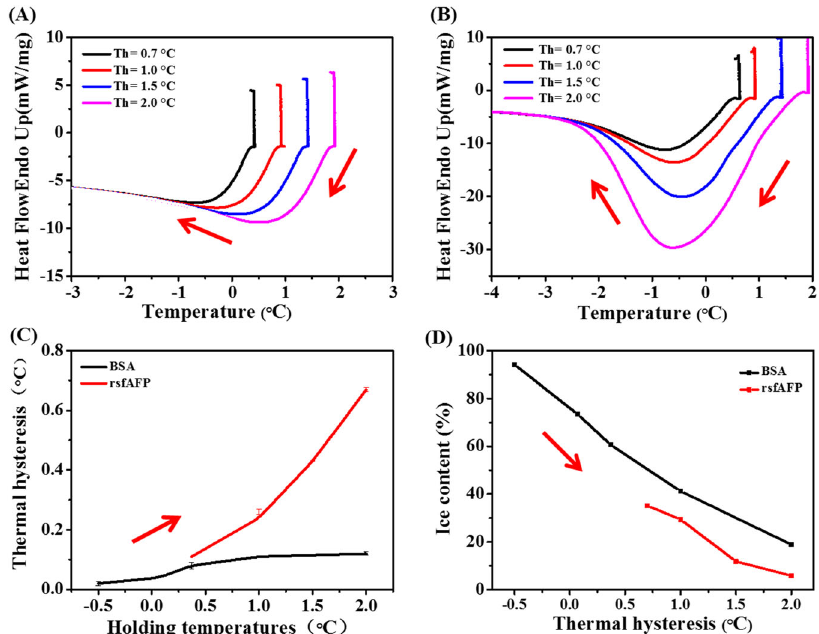
Fig. 2 Antifreeze activities of rsfAFP. The DSC thermogram of the freezing and melting processes at different holding temperatures for A BSA and B rsfAFP. C The thermal hysteresis activity of BSA and rsfAFP at different holding temperatures. D The ice content of BSA and rsfAFP at different thermal hysteresis. Data points represent mean values calculated from two separate